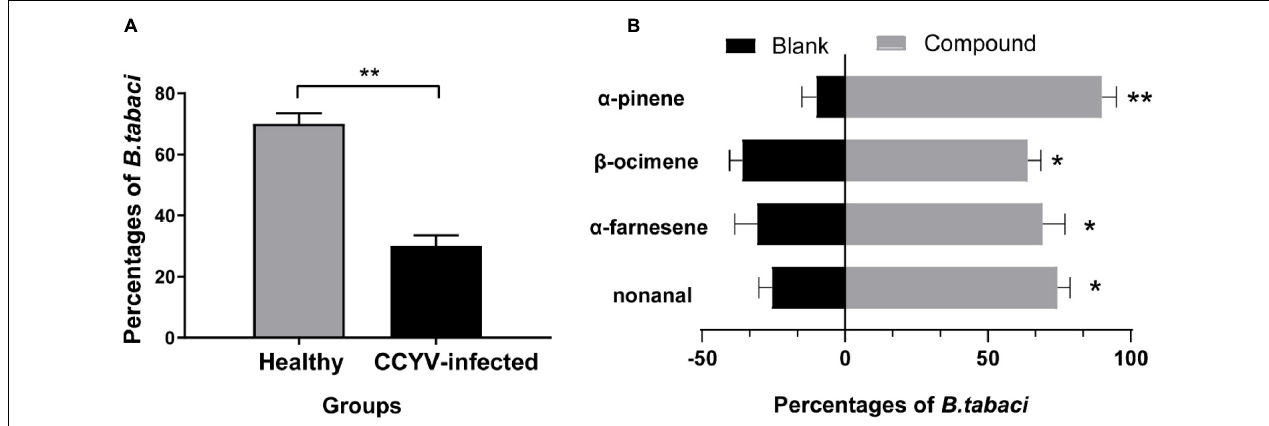
FIGURE 6 | Y-tube assay of B. tabaci to the odor of CCYV-infected and healthy Cucumis sativus plants (A) as well as to standard chemicals (B) . Columns show mean ± standard error (A); 0.1% diluted chemicals ( α -pinene: 0.860 ng/ µ l; β -ocimene: 0.818 ng/ µ l; α -farnesene: 0.862 ng/ µ l; nonanal: 0.827 ng/ µ l) were used in the Y-tube assay. Three replicates of 20 individuals were tested in each replication. In the olfactory assay of whiteflies to the odor of CCYV-infected and healthy cucumber plants, five replications were carried out. The number of B. tabaci was transferred into percentage and transformed with arcsine for analyzing difference under the one-sample t -test. “*” means p < 0.05, “**” means p < 0.01. We determined if the percentage differed significantly from the hypothesis of 50%.